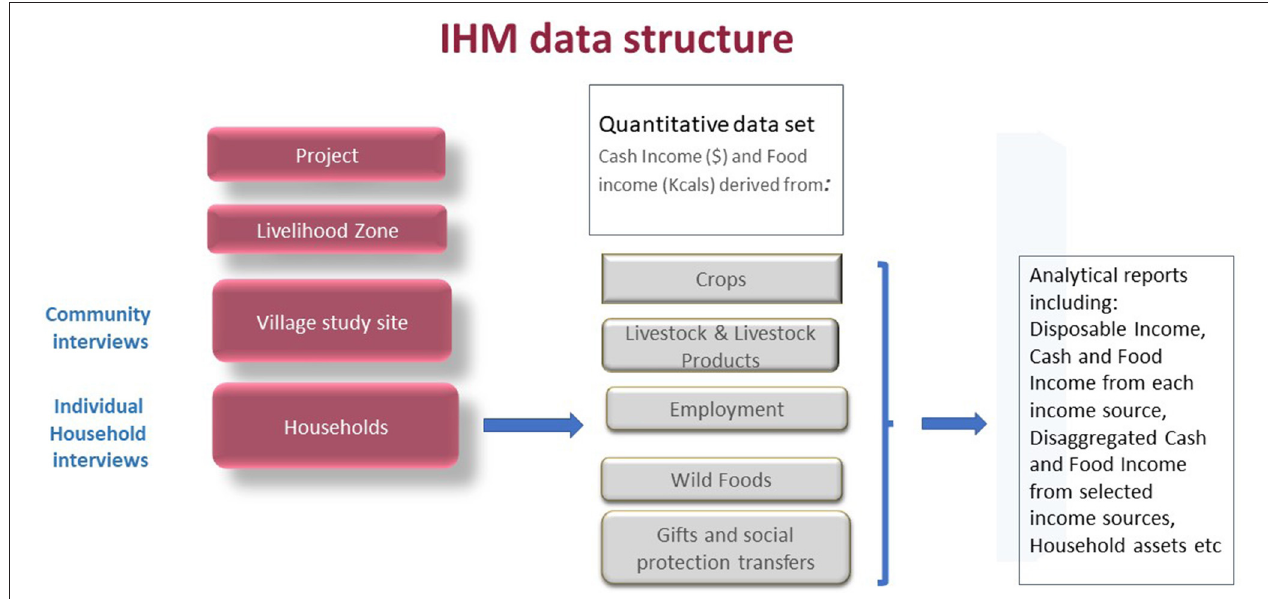
FIGURE 2 | The IHM data structure. Source: own elaboration based on images with “no copyright reserved” (Creative Commons Attribution Non Commercial No Derivatives 4.0 International